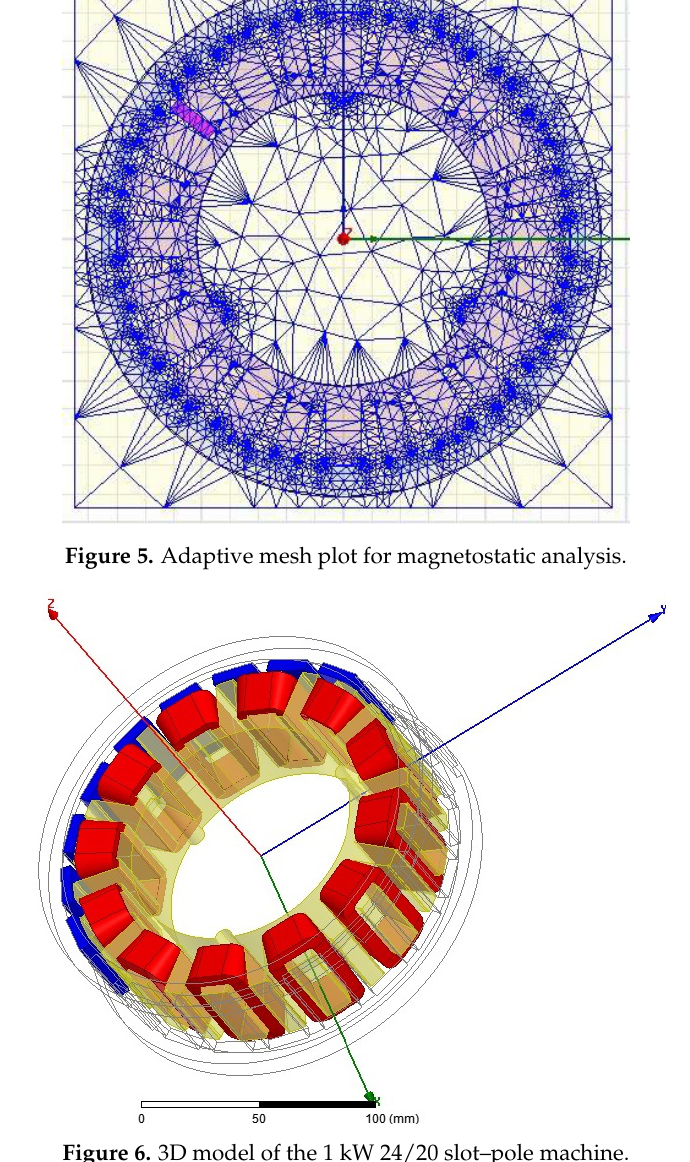
Figure 6. 3D model of the 1 kW 24/20 slot–pole